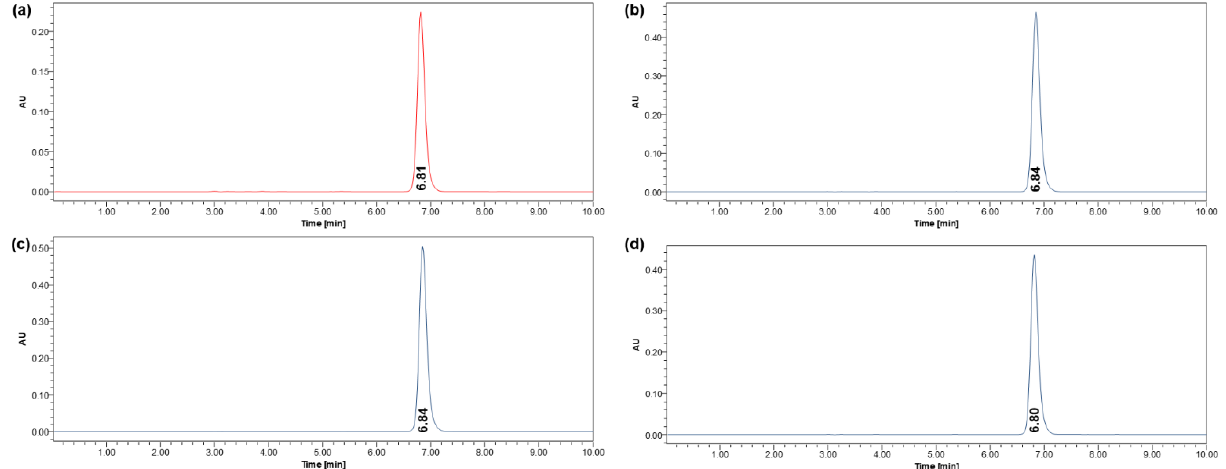
Figure 9. HPLC chromatogram of ( a ) neat Fen — retention time: 6.81, followed by physical mixtures between Fen and ( b ) P 407 — 6.84 min, ( c ) PCL — 6.84 min, and ( d ) PLA — 6.80 min.